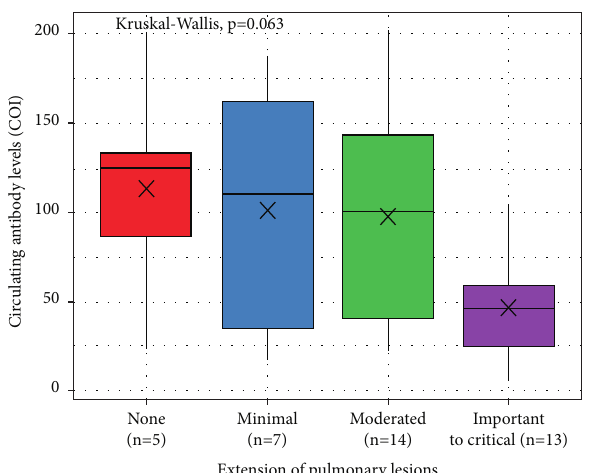
Figure 3: Comparison of the circulating levels of antibodies against SARS-CoV-2 in the different subgroups of hemodialysis patients according to the degree of pulmonary extension lesions by using the Kruskal–Wallis